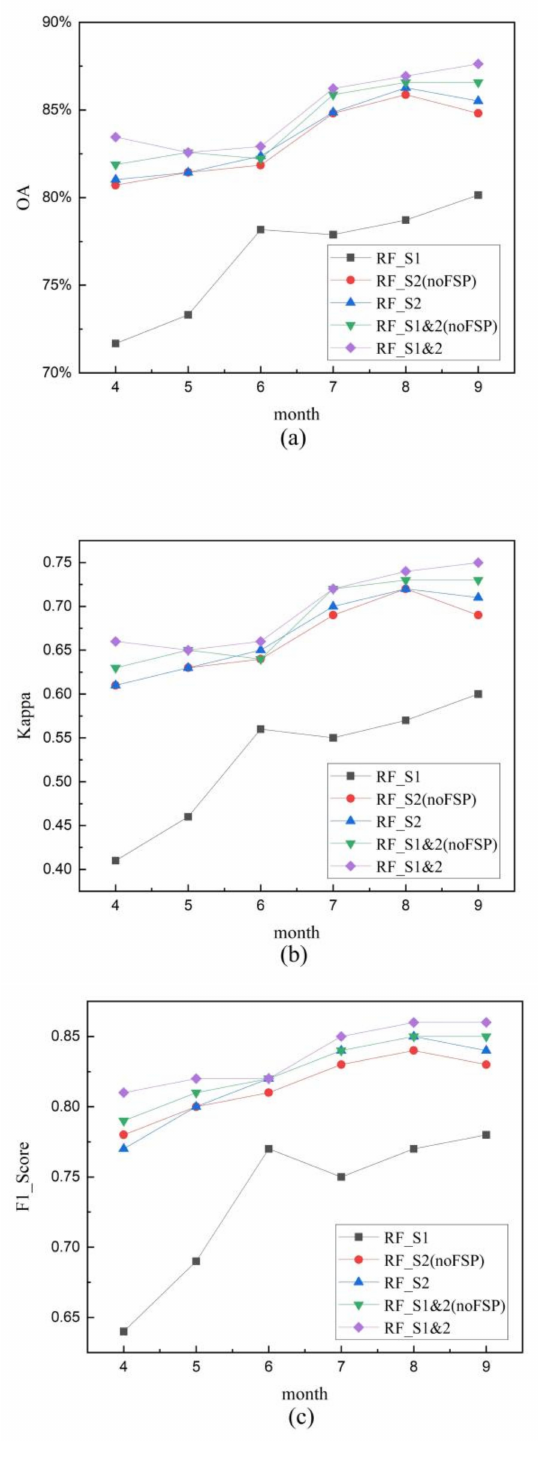
Figure 8. Performance comparison of different RF models constructed by incremental learning and feature selection. “noFSP” means that the feature selection procedure is not used. In the figure, the month marked on the abscissa means that the input features of the RF model include the data of that month and previous